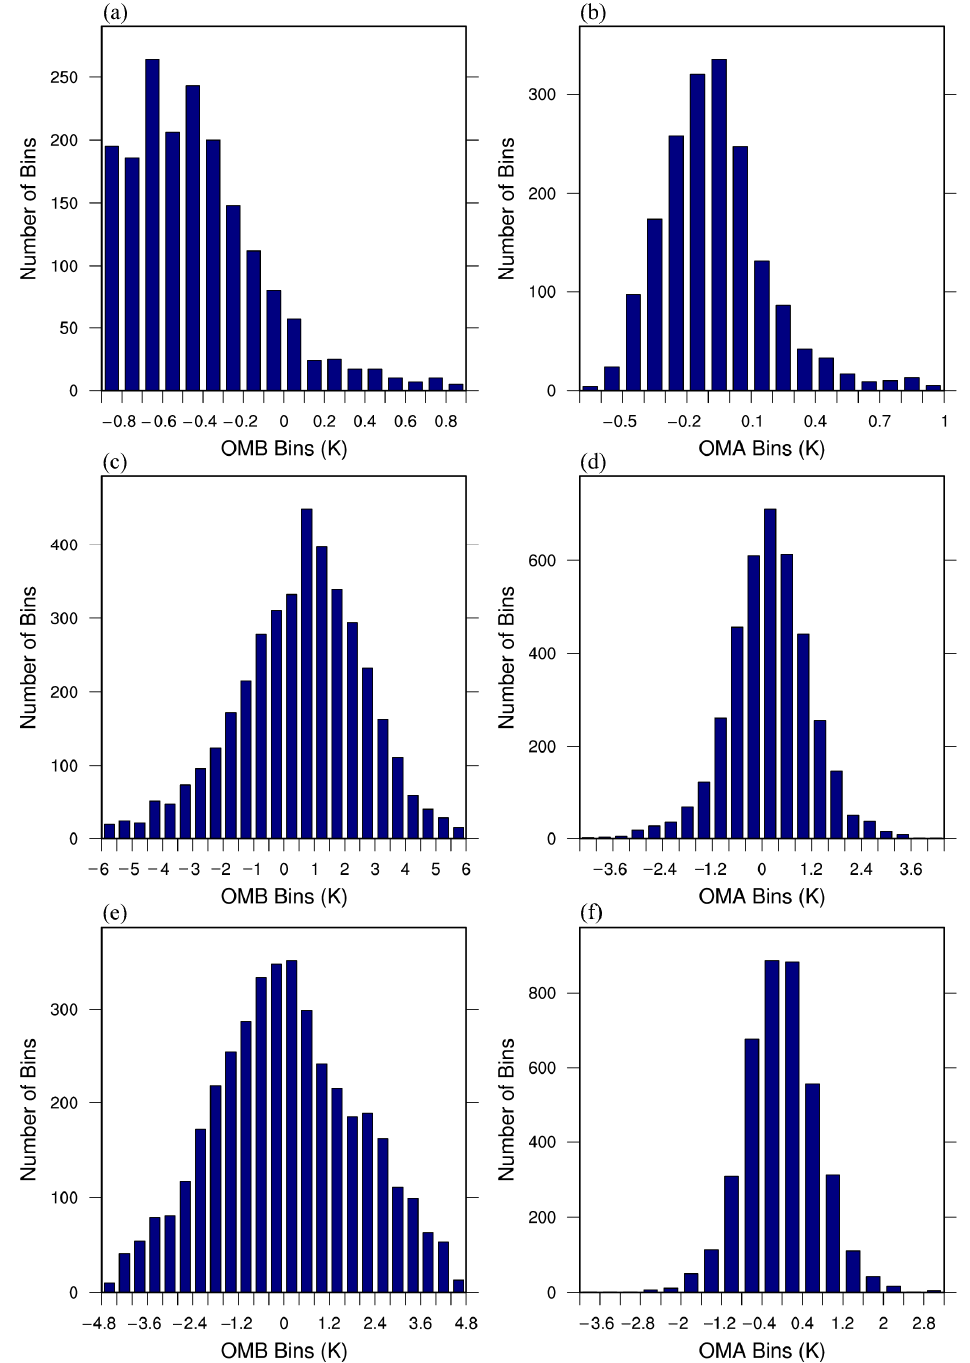
Figure 4. Frequency histograms of ( a , c , e ) background fields and ( b , d , f ) analysis fields after bias correction at 0600UTC on 22 July 2018, with NOAA-19 AMSUA channel 5 in the upper row, NOAA-19 MHS channel 4 in the middle row, and FY-3D MWHS2 channel 11 in the lower row.